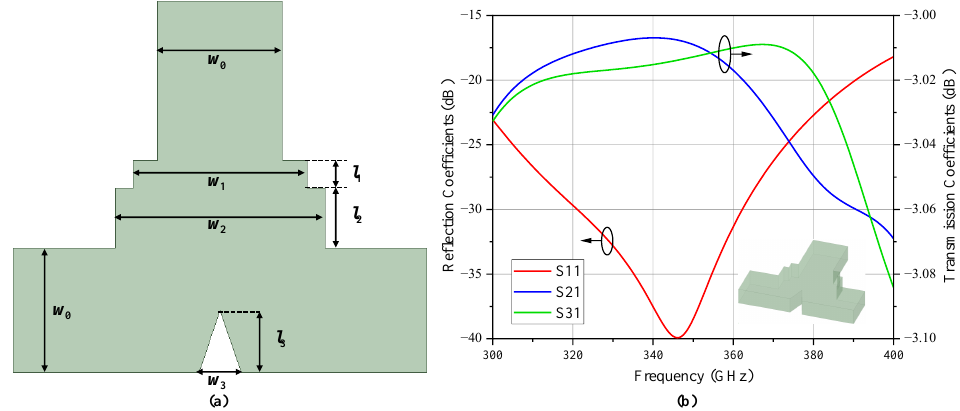
Figure 7. ( a ) The configuration of the 2-way waveguide power divider. ( b ) The simulation resulted of the above power